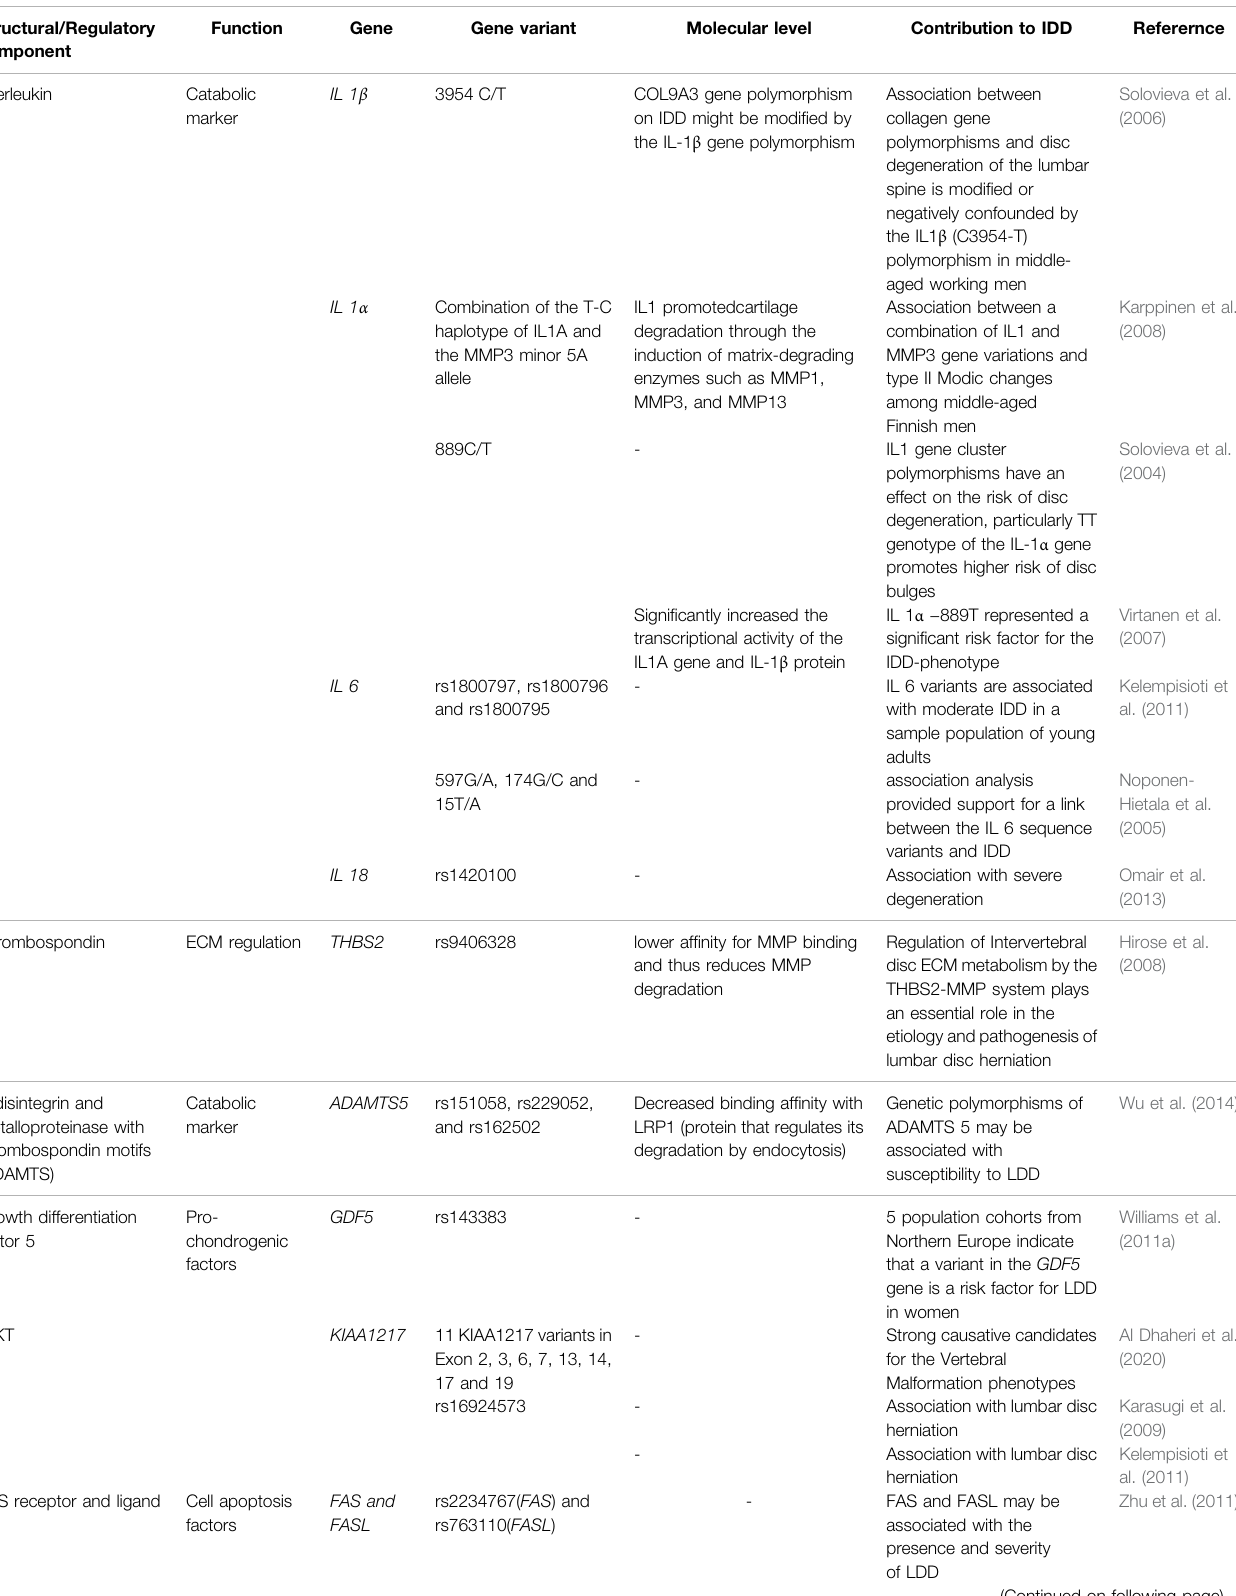
TABLE 1 | ( Continued ) Gene variants of structural/regulatory components of IVD associated with IDD by candidate gene